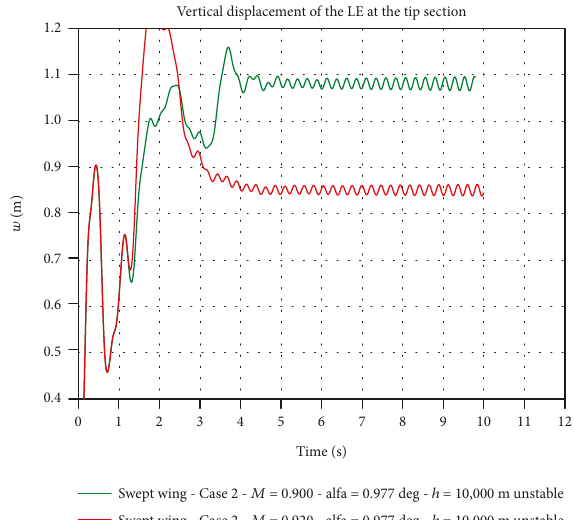
Figure 37: FSI DB — displacement histories at the LE of the swept-wing tip (Case 2, α = 0 977 °